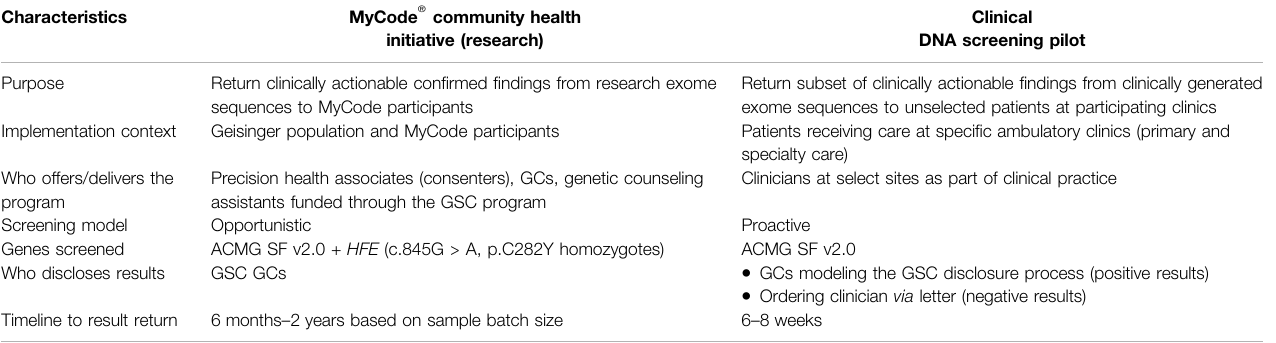
TABLE 1 | Key characteristics of two Geisinger DNA screening programs.